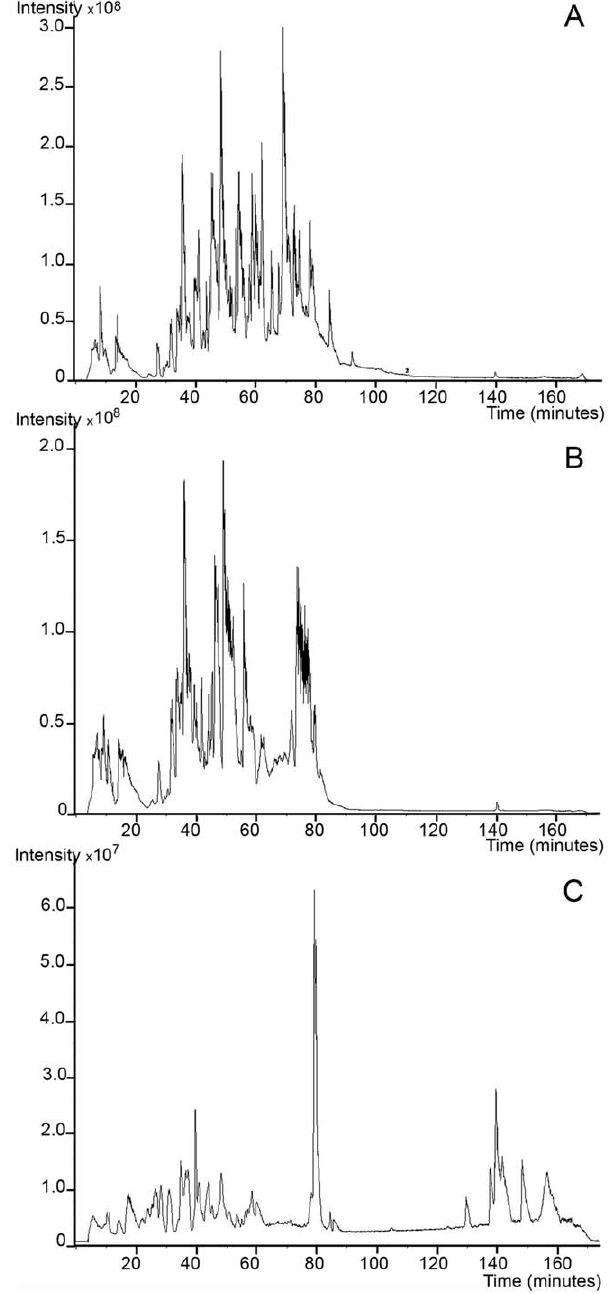
Figure 2. Quality comparison of MS profiles of native protein mixture and tissue surrogate extracts. FFPE tissue surrogates were heated in 50 mM Tris, pH 8 + 2% SDS at either elevated pressure (40,000 psi) or atmospheric pressure. The extracts were analyzed by LC/ MS and the MS traces of each tissue surrogate extract was compared to the native, unfixed protein mixture. A) native, unfixed tissue surrogate mixture; B) FFPE tissue surrogate retrieved at 40,000 psi; C) FFPE tissue surrogate retrieved at atmospheric pressure (14.7 psi).